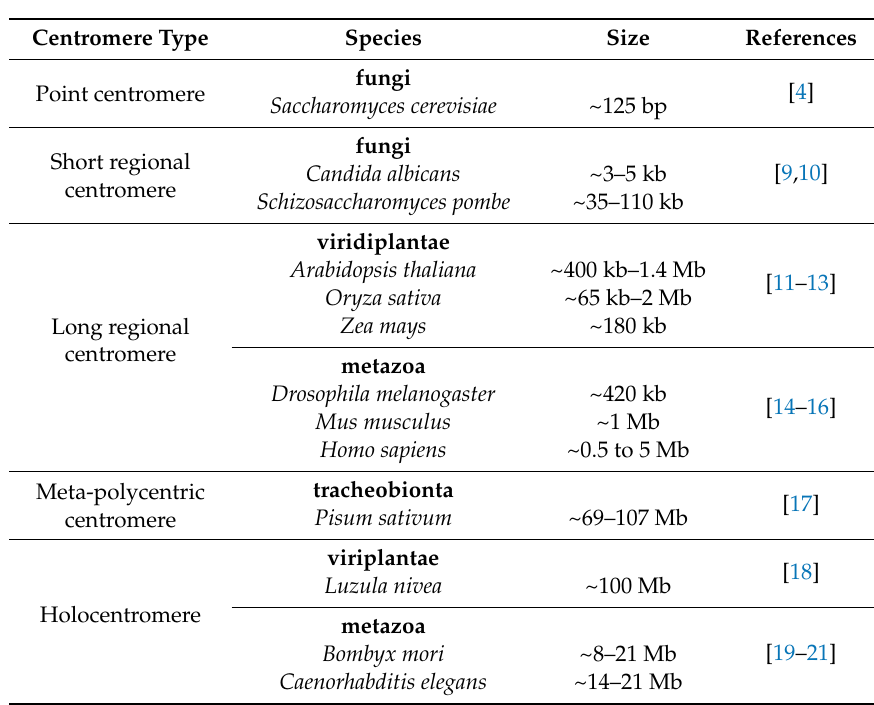
Table 1. Centromere structure in di ff erent species.